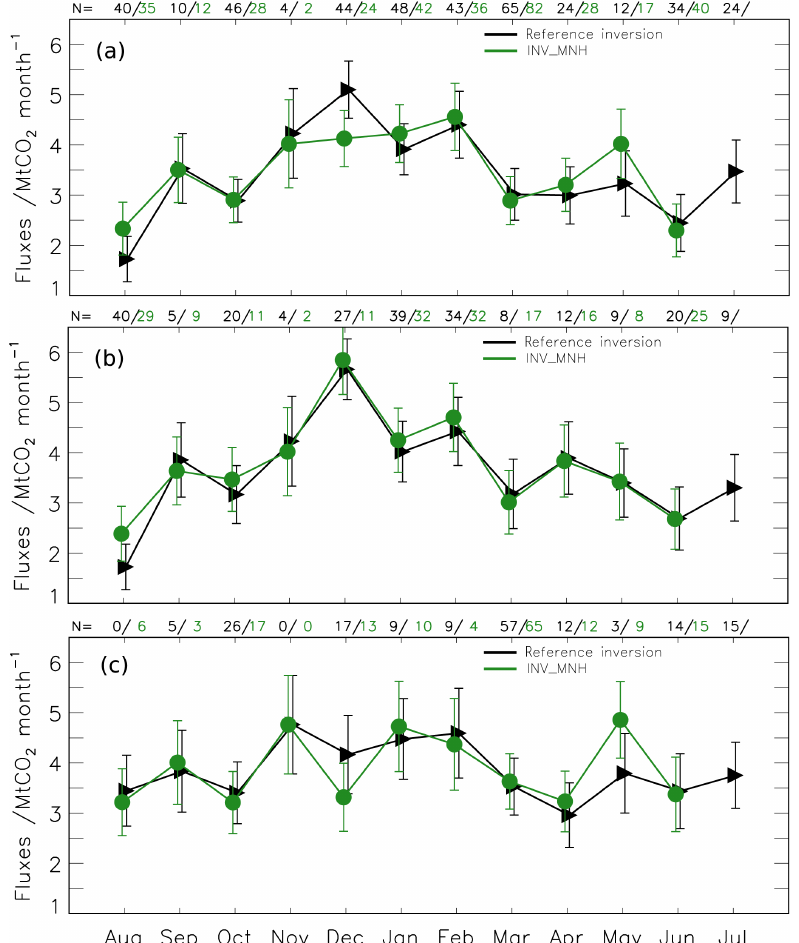
Figure 8. Sensitivity of monthly fossil fuel CO 2 budgets on meteorological data. Displayed are the estimates ± the standard deviation of their uncertainties obtained from the reference inversion (green) and INV_MNH (black), respectively. Numbers at the top denote the colour-coded number of assimilated gradients. (a) Assimilation of both SW and NE gradients. (b) Assimilation of SW gradients. (c) Assimilation of NE